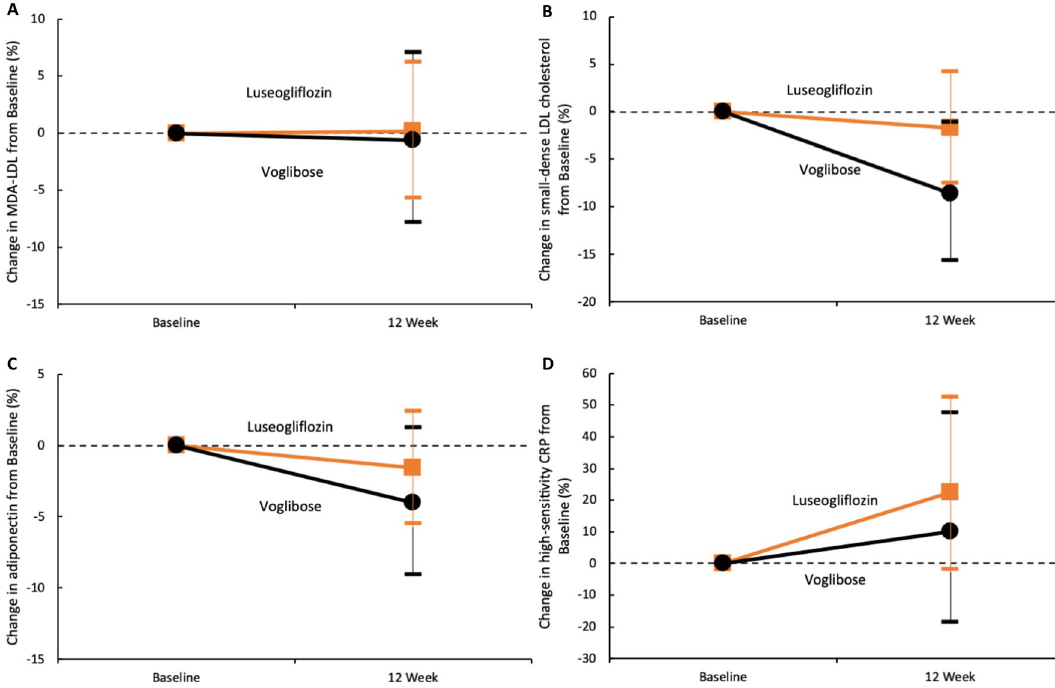
Figure 2. Changes in the high-risk lipid profile or inflammatory markers from baseline. The orange squares and lines (luseogliflozin group) or black circles and lines (voglibose group) indicate the mean changes and 95% confidence intervals of each marker, relative to the baseline. Each value is represented in Table 2. MDA-LDL malondialdehyde low-density lipoprotein, CRP C-reactive protein.